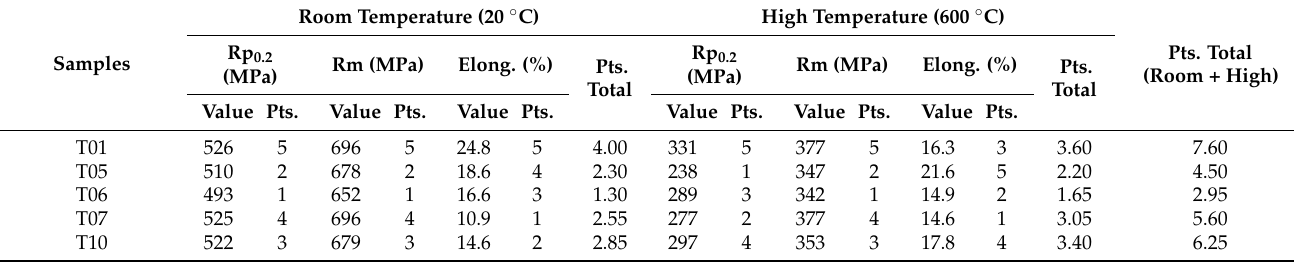
Table 11. Summary of the sample’s results for the tensile tests.